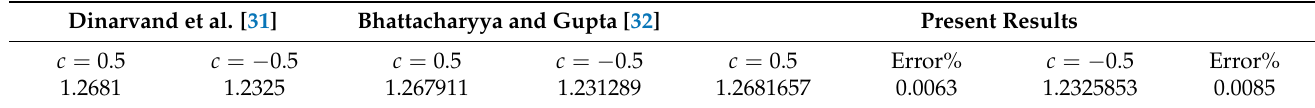
Table 2. Comparison of Re x 1/2 C fx in the x -axis coordinates with results from previously published work for the pure normal fluid when ϕ = 0 and λ = 0. Furthermore, the error% was calculated from [31].